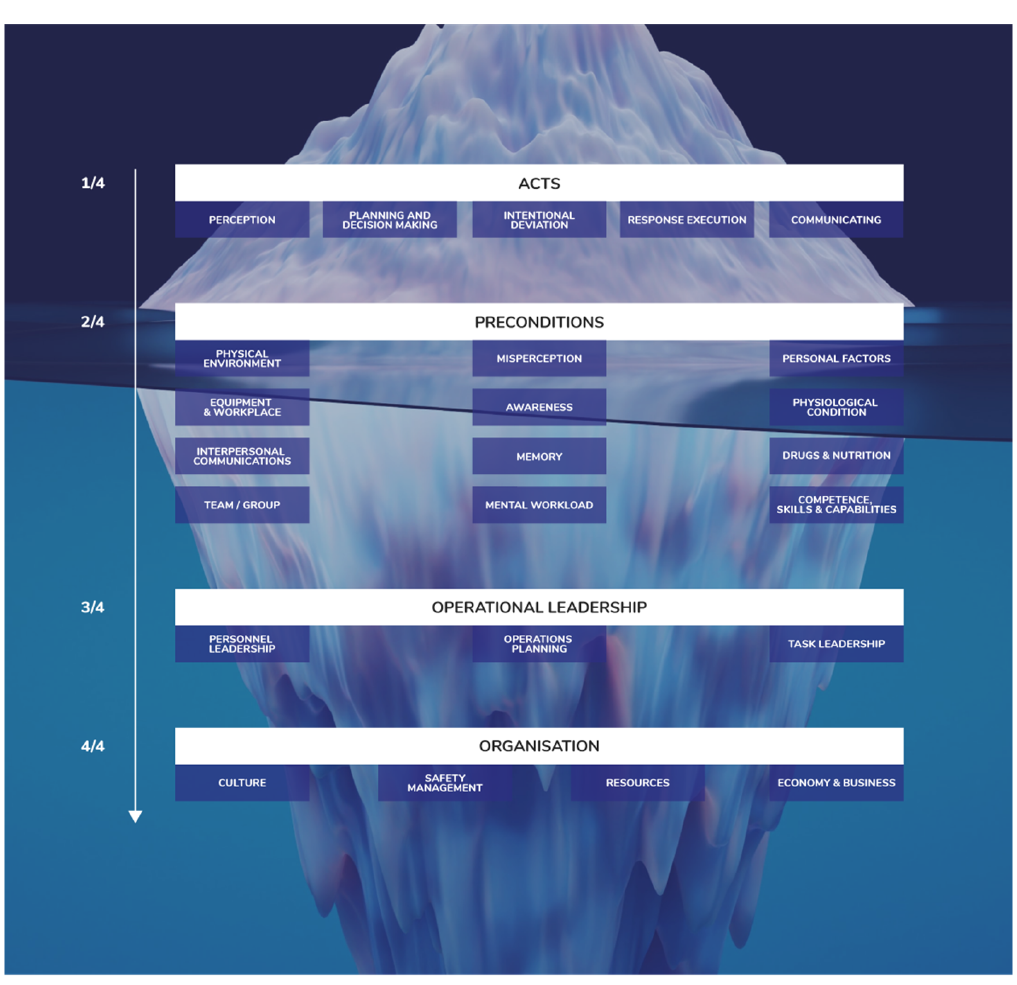
Figure 1. Illustration of the SHIELD HF taxonomy over a Safety Iceberg.